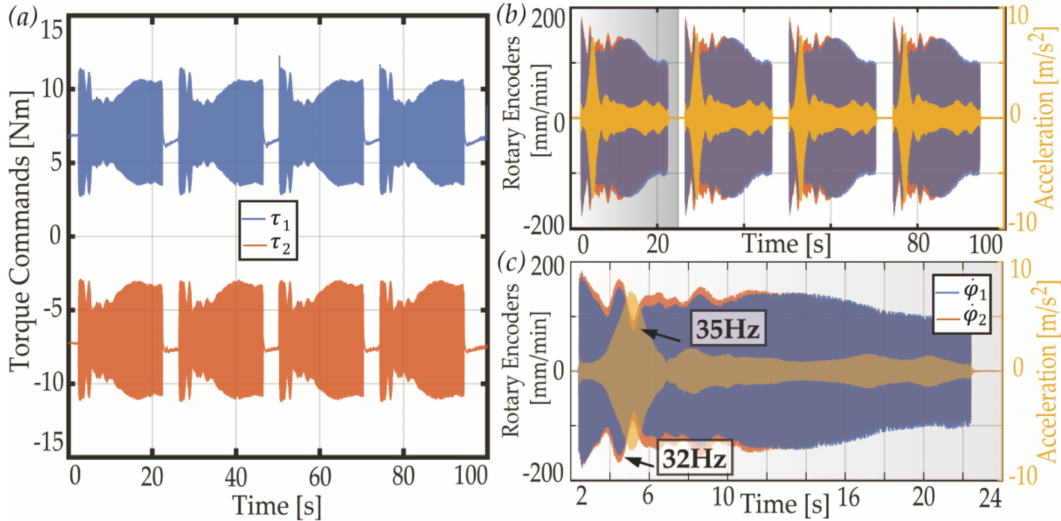
Figure 9. Time-domain signals for ( a ) torque commands, ( b , c ) rotary encoders and acceleration